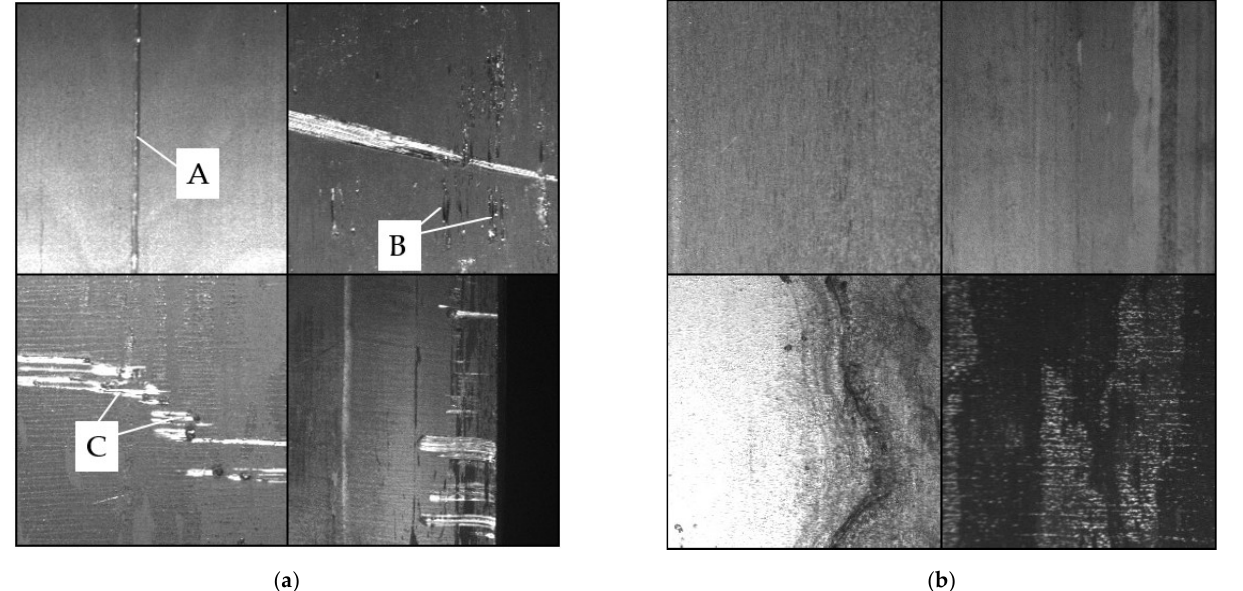
Figure 1. Examples of scratches (A), scrapes (B) and abrasions (C) ( a ) and undamaged surfaces ( b